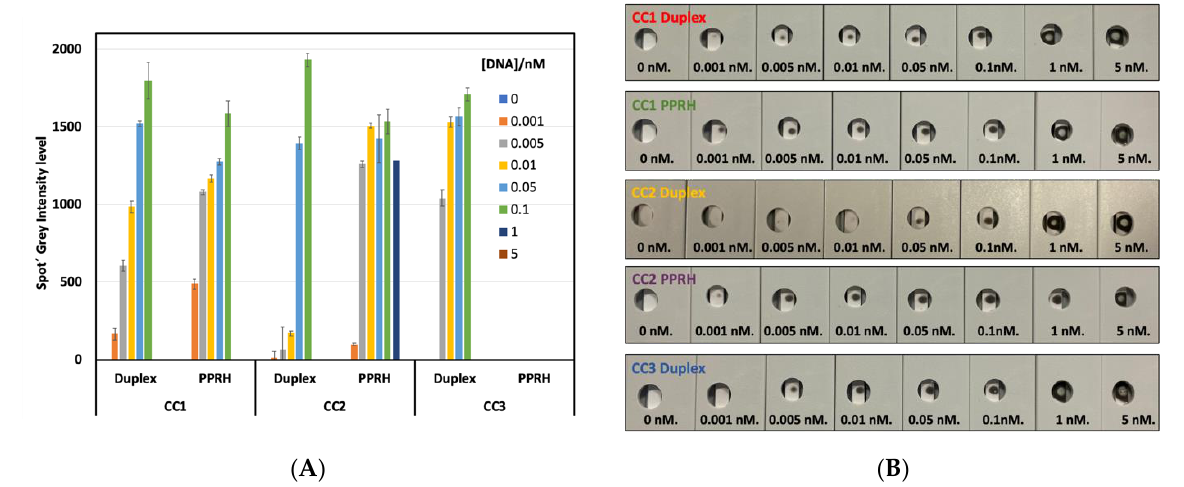
Figure 6. Results obtained with the thermal lateral flow system. ( A ): Profile of ipeak ® (IUL S.A. commercial lateral flow reader) quantification of spiked samples with different concentrations of targets (from 0 to 5 nM) in UTM using capture sequences duplex-CC1, CC2, and CC3 duplex and PPRH-CC1 and CC2. Results with PPRH-CC3 sequence are not shown in this graph because NPRs aggregation was observed during the testing assay. Grey level intensity measurements were obtained from the LF reader to determine the value of LOD of the thermal lateral flow system. Standard deviation of three replicates carried out consecutively is drawn as error bars. ( B ): Image obtained from the back part of the LF strips (thermosensitive material) after the laser irradiation using a 1064 nm laser. The strips were loaded with spiked samples in UTM from Biocomma with different concentrations of DNA, from 0–5 nM, to determine the visual LOD of the